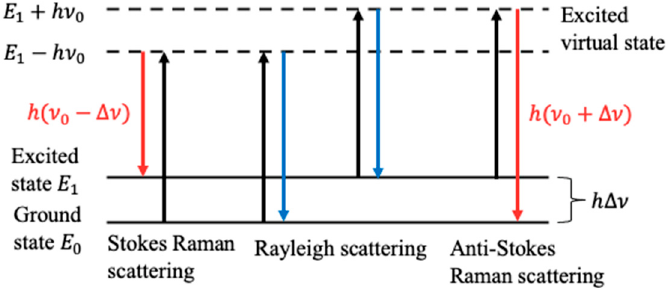
Figure 1. Rayleigh scattering and Raman scattering energy level diagram. Reproduced with permission [10].